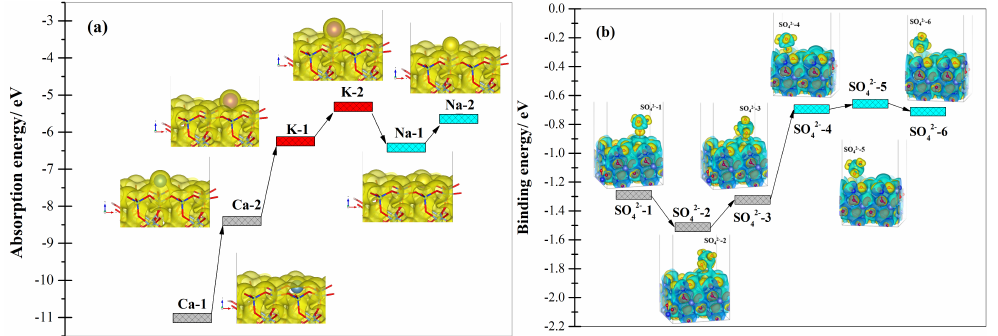
Figure 14. Absorption energy profile of Ca 2+ , K + , and Na + on muscovite (001) surface ( a ) and binding energy of Ca 2+ and SO 42− on muscovite (001) surface ( b ).